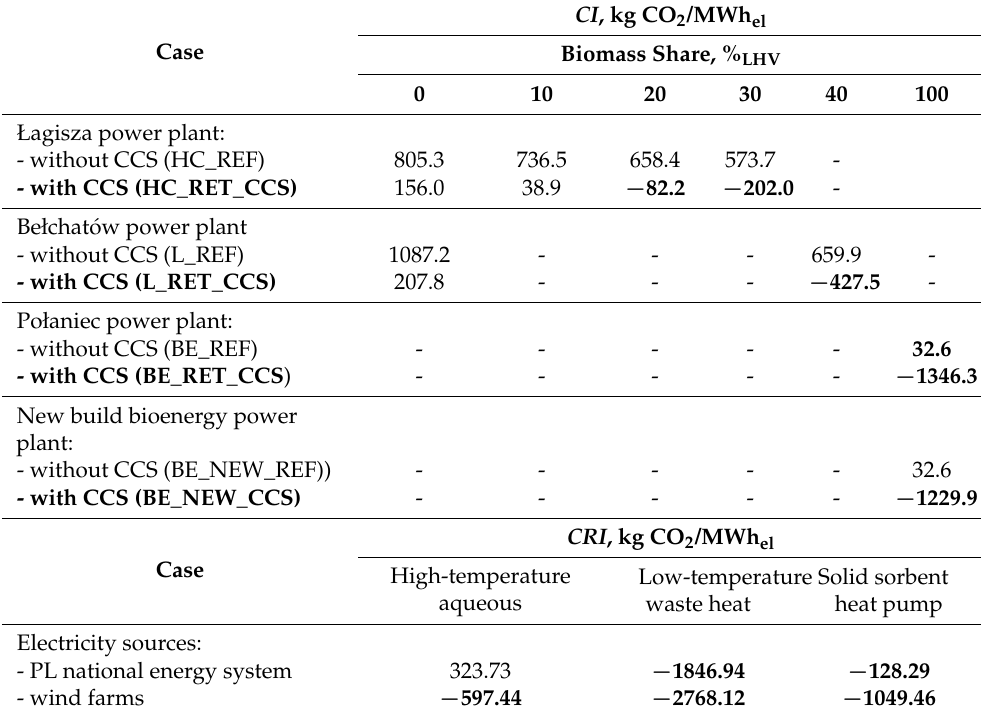
Carbon Intensity and Carbon Removal Intensity of analyzed power plants and DAC installations.